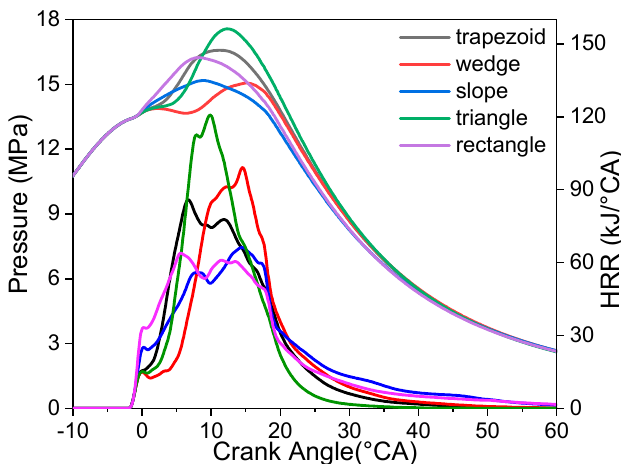
Figure 4. The in-cylinder pressure and HRR profiles for different injection rate shapes.